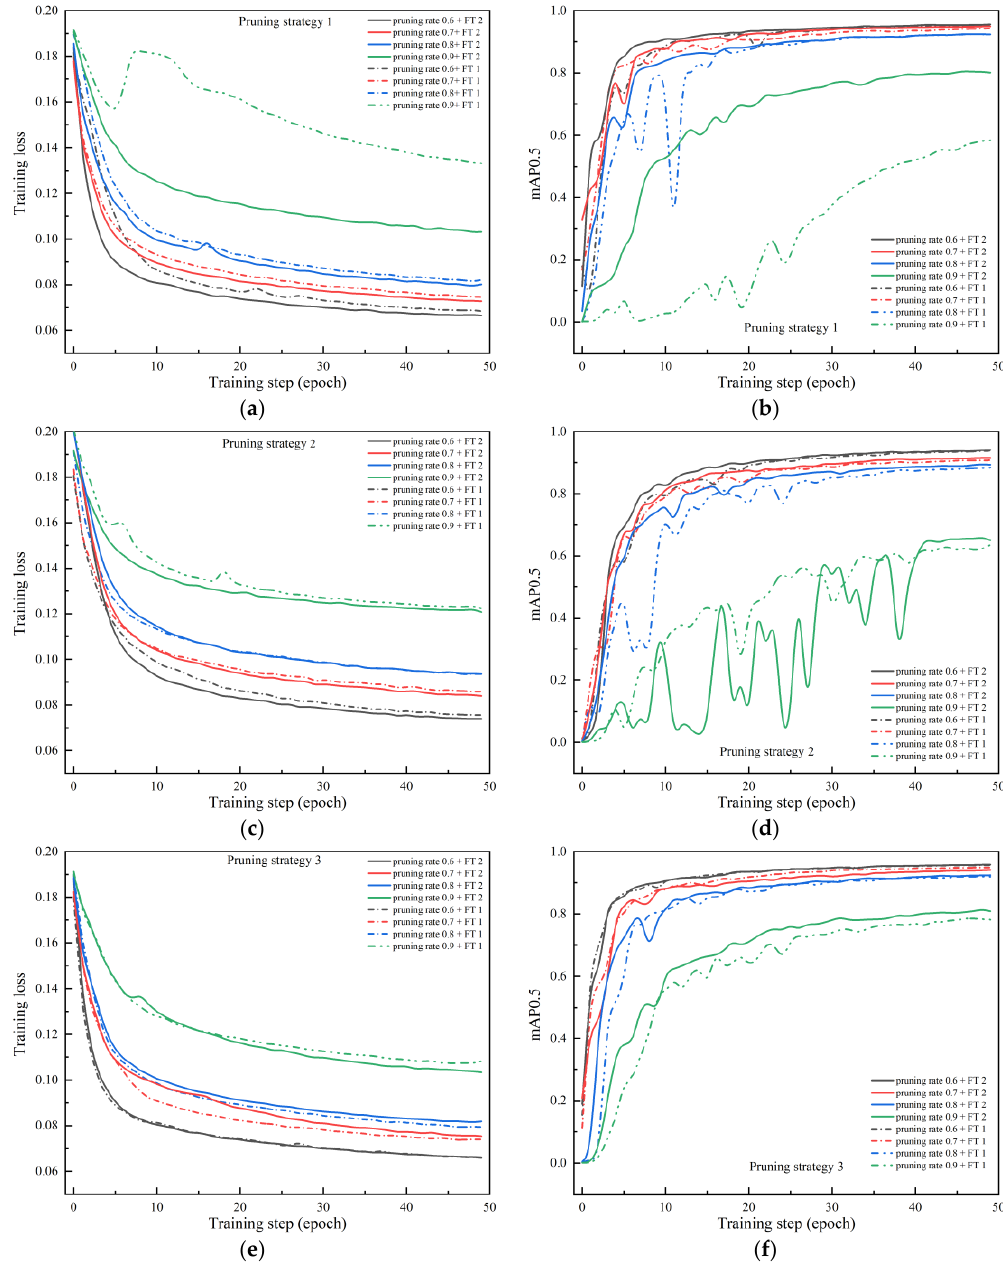
Figure 6. Loss and accuracy changes of three pruned networks under two fine-tuning methods. ( a ) Loss changes of pruning strategy 1. ( b ) Accuracy changes of pruning strategy 1. ( c ) Loss changes of pruning strategy 2. ( d ) Accuracy changes of pruning strategy 2. ( e ) Loss changes of pruning strategy 3. ( f ) Accuracy changes of pruning strategy